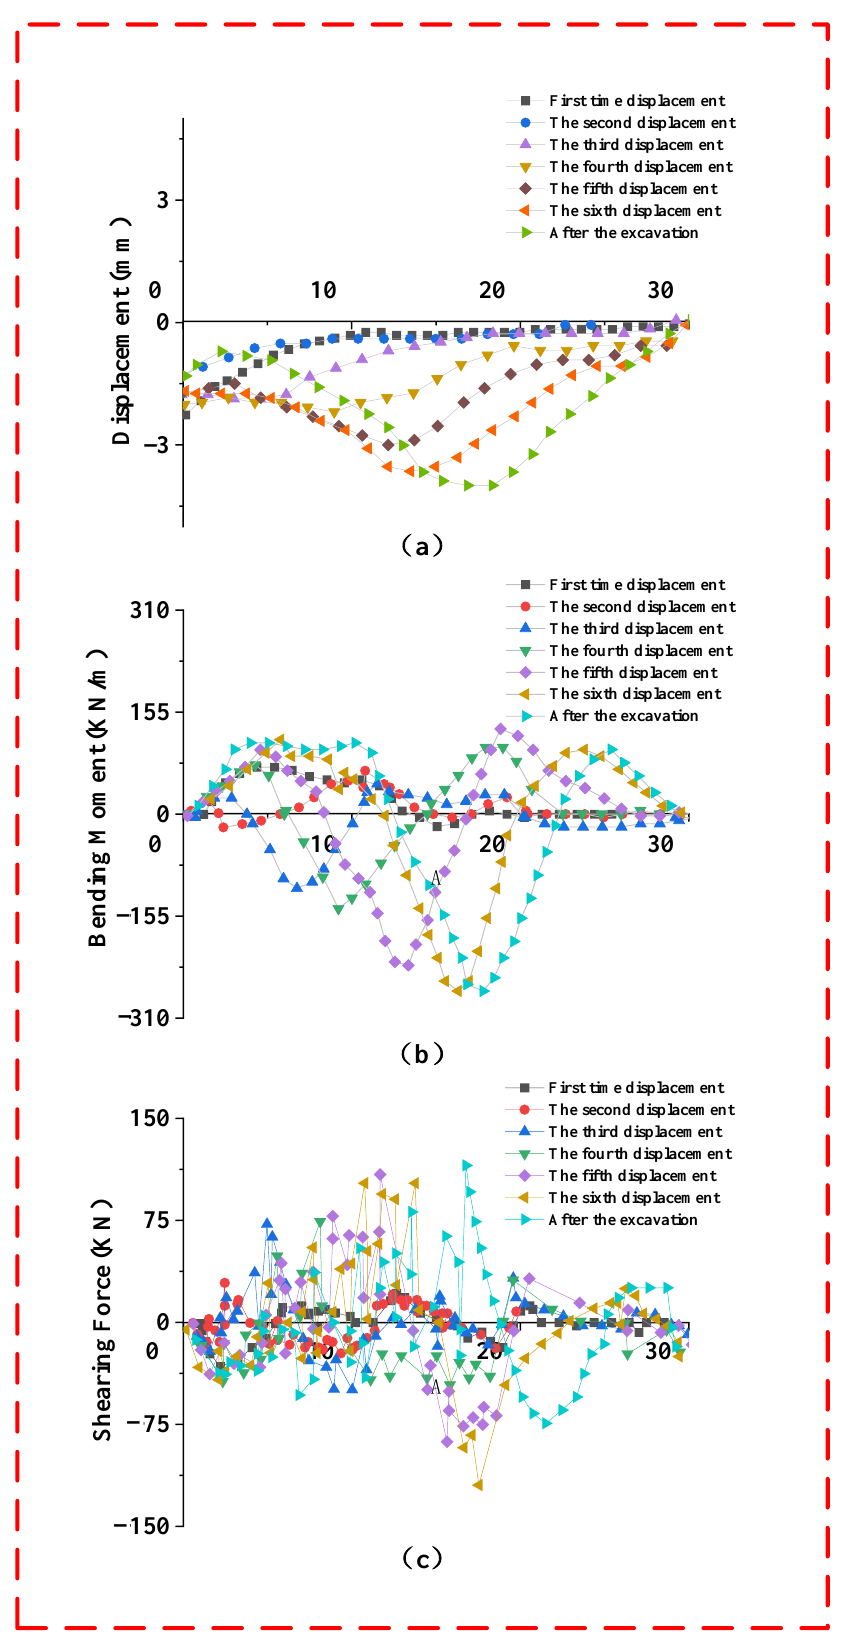
Figure 5. Results of the elastic foundation beam algorithm: ( a ) displacement map; ( b ) curved moment diagram; ( c ) shear